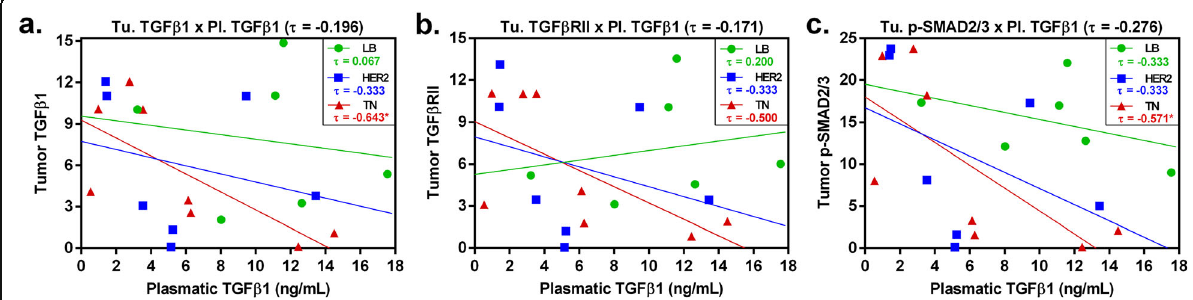
Fig. 5 Correlation between plasmatic (Pl.) TGF β 1 levels and tumor tissue (Tu.) staining for TGF β 1 ( a ), TGF β RII ( b ) and p-SMAD2/3 ( c ). Dots are shape-coded and colored according to the subtype: green circles represent samples from Luminal-B (LB) subtype, blue squares represent samples from HER2-enriched (HER2) subtype and red triangles represent samples from triple-negative (TN) subtype. Regression lines and Tau-b coefficients are also shown following the same color code. LB: Luminal-B-HER2 + subtype. HER2: HER2-enriched subtype. TN: triple-negative